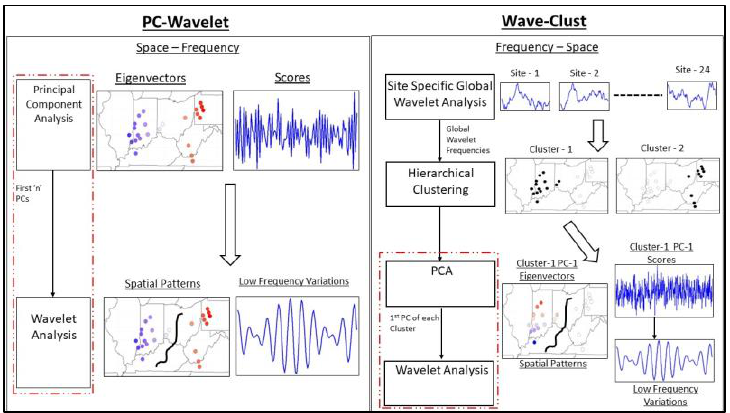
Figure 3. Schematic of methods for time series analysis of multi-site streamflow data to analyze low frequency variation, non-stationarity, and space-time signatures of streamflow extremes. ( left )—PC- Wavelet. ( right